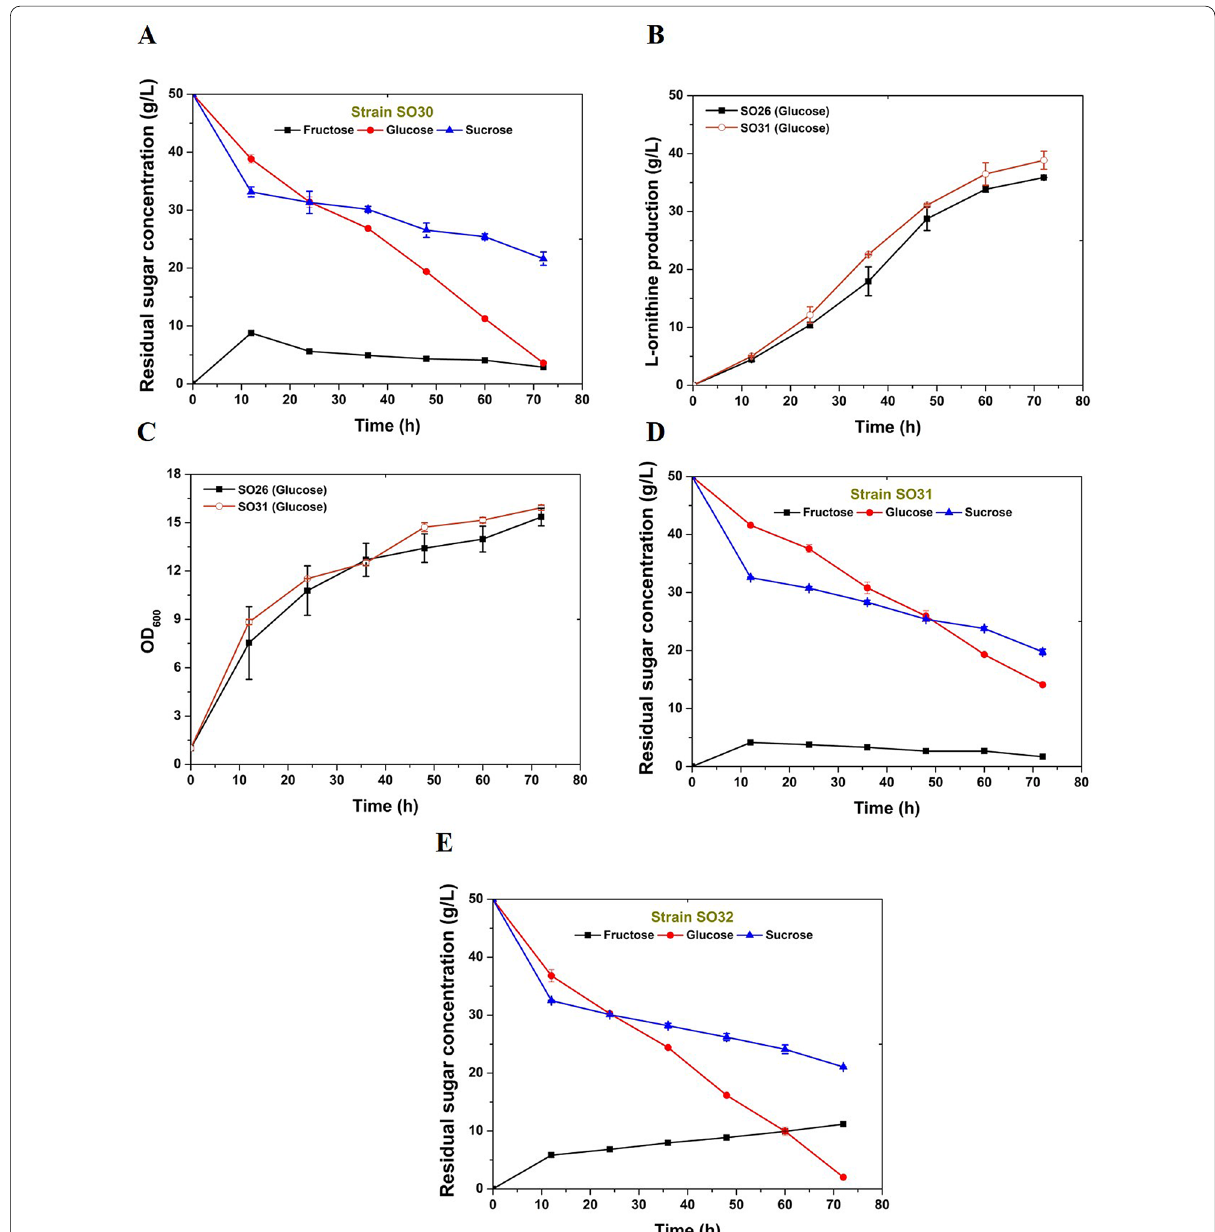
Fig. 4 Deletion of pfkB2 promotes l -ornithine accumulation in C. glutamicum SO26. A Sugar consumption of C. glutamicum SO30 cultivated on glucose plus sucrose. Black square represents fructose, red cycle represents glucose, and blue triangle represents sucrose. B l -Ornithine production curves of strain C. glutamicum SO26 (solid black square) and SO31 (with pfkB2 deletion, hollow red cycle) cultivated on glucose. C Cell growth curves of strain C. glutamicum SO26 (solid black square) and SO31 (hollow red cycle) cultivated on glucose. D Sugar consumption of C. glutamicum SO31 cultivated on glucose plus sucrose. Black square represents fructose, red cycle represents glucose, and blue triangle represents sucrose. E Sugar consumption of C. glutamicum SO32 cultivated on glucose plus sucrose. Black square represents fructose, red cycle represents glucose, and blue triangle represents sucrose. Data are averages and standard deviations from three independent